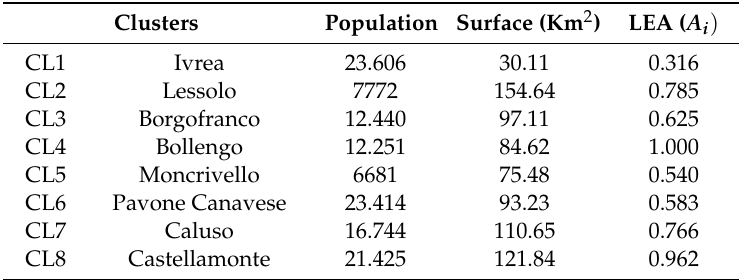
Table 4. Parameters of the dynamic model for the MAI landscape.